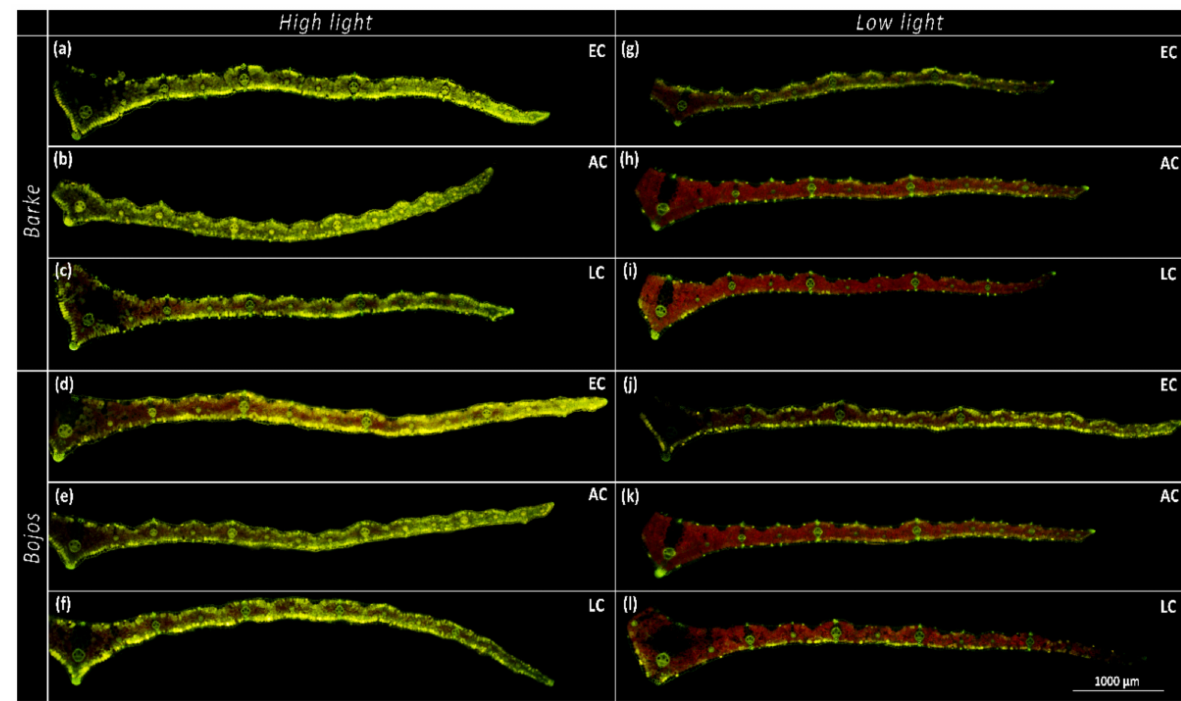
Figure 4. Cross-sections of barley ( Hordeum vulgare ) leaves for each treatment, showing the clear effect of high light intensity, and elevated [CO 2 ], on leaf phenolic compounds, 40 × magnification, treated with Naturstoff reagent A and excited under blue light–half leaf lamina shown from midrib (left) to leaf margin (right). Left column of images shows high light (HL) treatment, right column shows low light (LL) treatment. [CO 2 ] is denoted in frame on right as elevated (EC), ambient (AC), or low (LC). Barke ( a ) EC-LL; ( b ) AC-LL; ( c ) LC-LL; ( g ) EC-HL; ( h ) AC-HL; ( i ) LC-HL. Bojos ( d ) EC-LL; ( e ) AC-LL; ( f ) LC-LL; ( j ) EC-HL; ( k ) AC-HL; ( l )